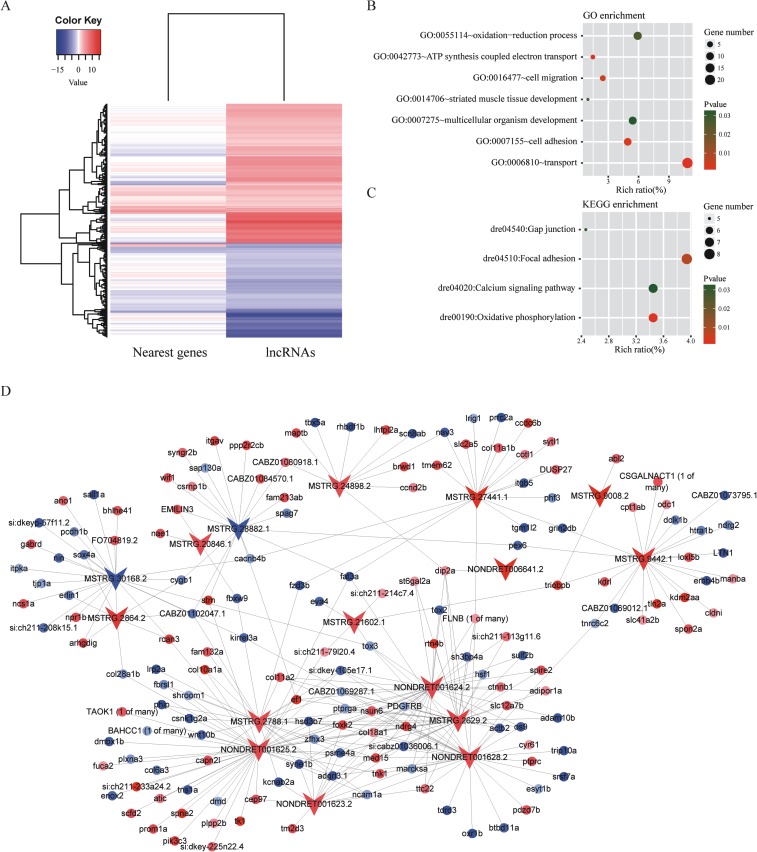
Predicted target genes of the differential expressed lncRNAs.(A) A heatmap was generated from the fold change values in the RNA-Seq data, and was used to visualize the expression patterns of the cold responsive lncRNAs and their neighboring genes after cold acclimation. (B-C) GO and KEGG enrichment analyses of the differentially expressed genes adjacent to the differentially expressed lncRNAs. The y-axis corresponds to KEGG pathway with a p-value ≤ 0.05, and the x-axis shows the enrichment ratio between the number of DE-genes and all unigenes enriched in a particular pathway. The color of the dot represents p value, and the size of the dot represents the number of DE-genes mapped to the reference pathways. (D) Regulatory network of 16 DE-lncRNAs with the lowest FDR, was built by Cytoscape 3.5. The triangles denote representative lncRNAs and the dots represent the trans-target genes. The colors represent log-transformed fold change. Blue: down-regulated; red: up-regulated.